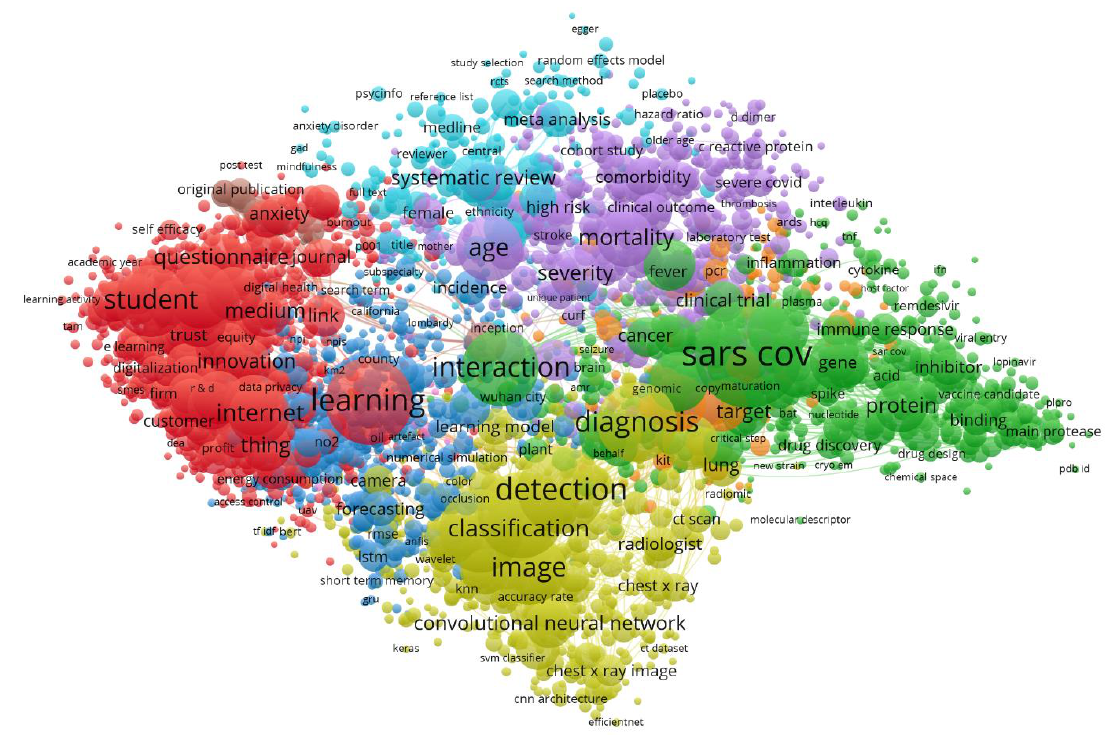
Figure 7. Topic mapping and clustering based on affinities (source Scopus).